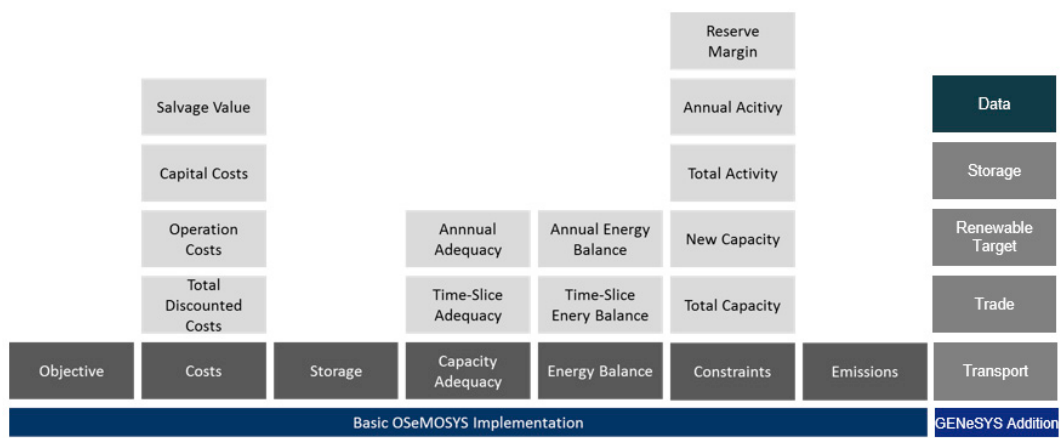
Figure 1. Blocks of functionality of GENeSYS-MOD (the illustration is based on Howells et al. [20]).